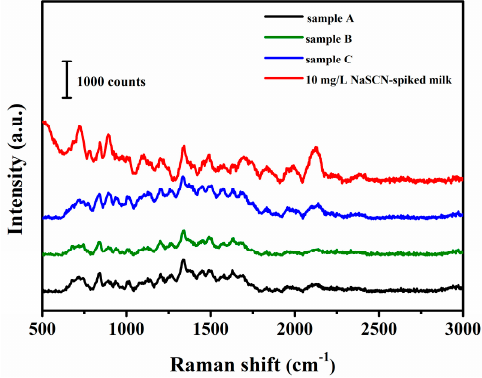
Figure 6. The SERS spectra of three kinds of commercial milk samples and spiked milk.